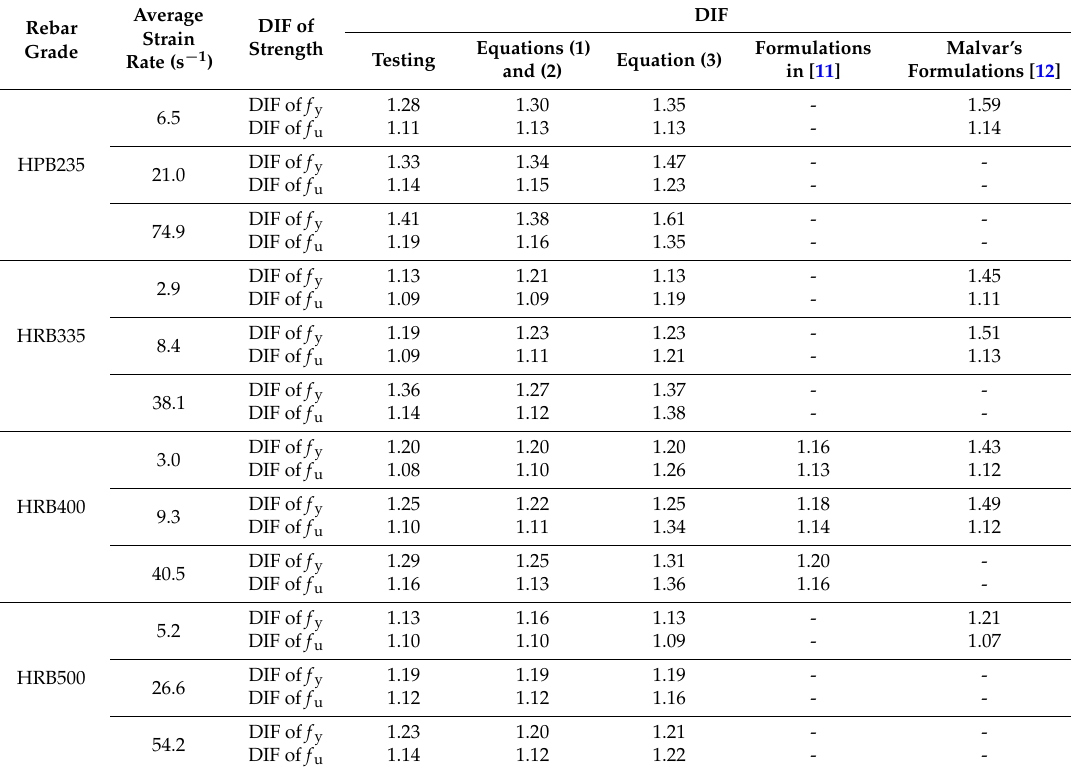
Table 4. Comparison among DIFs of yield and ultimate strengths obtained from different sources. Rebar